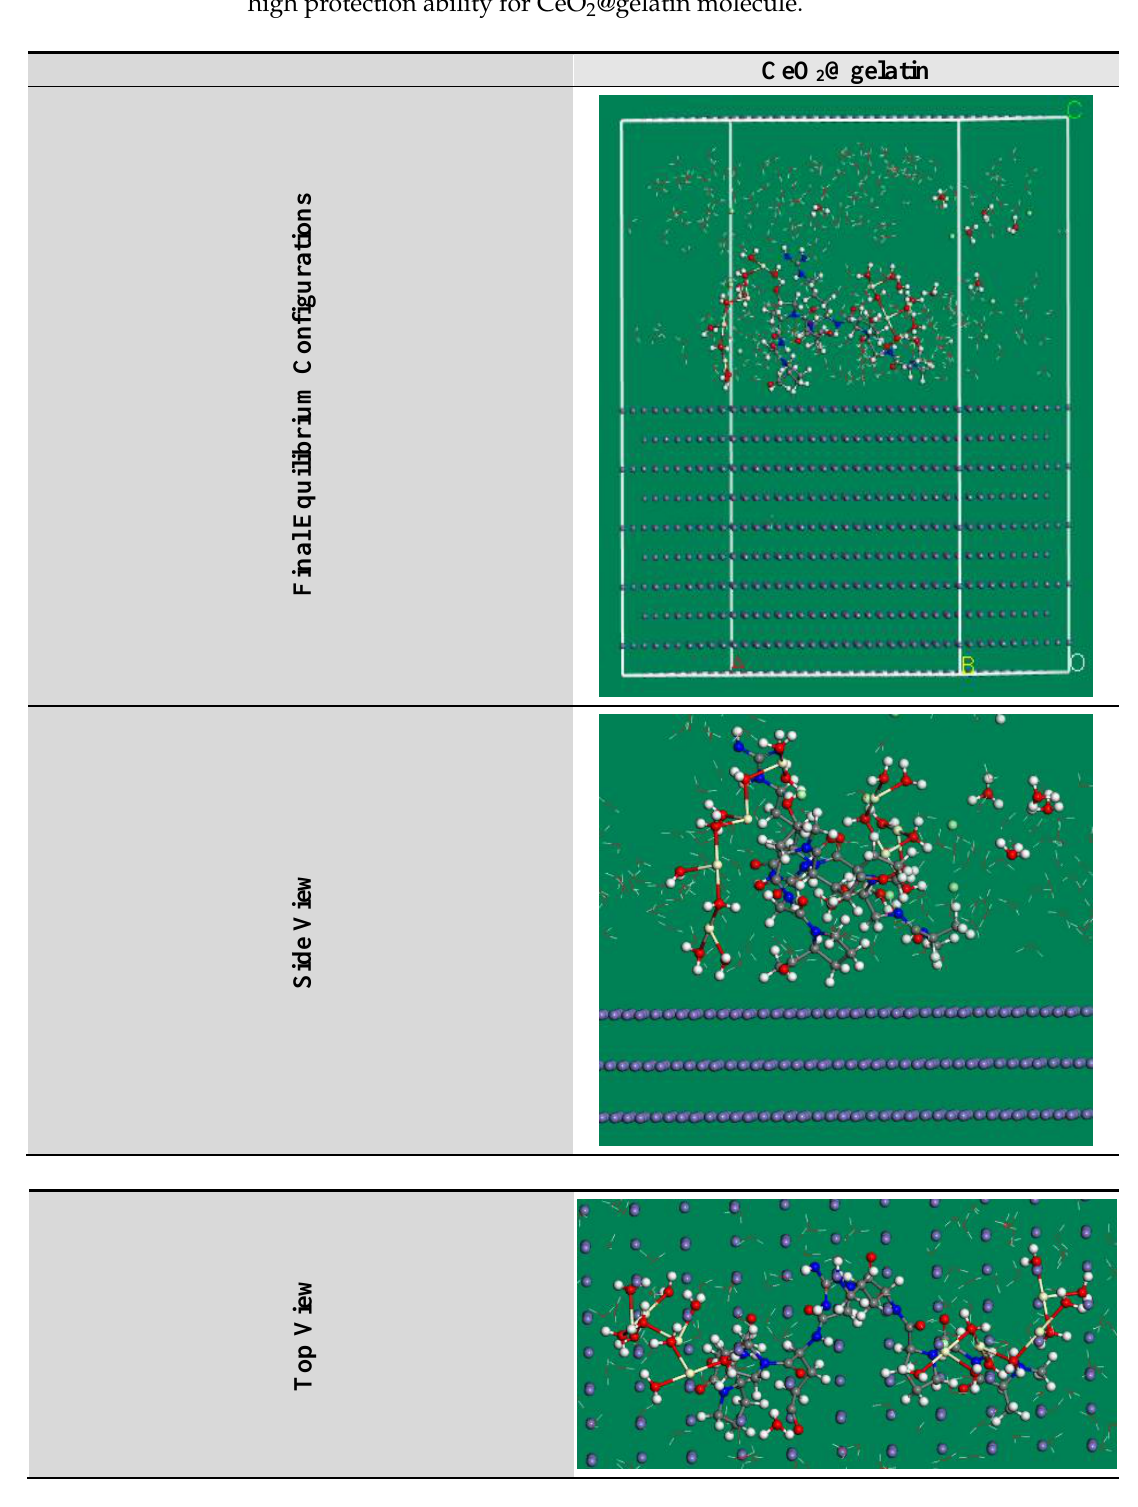
Figure 13. The highest proper adsorption arrangement for the CeO 2 @gelatin molecule on the Fe (1 1 0) substrate achieved by the adsorption locator module.